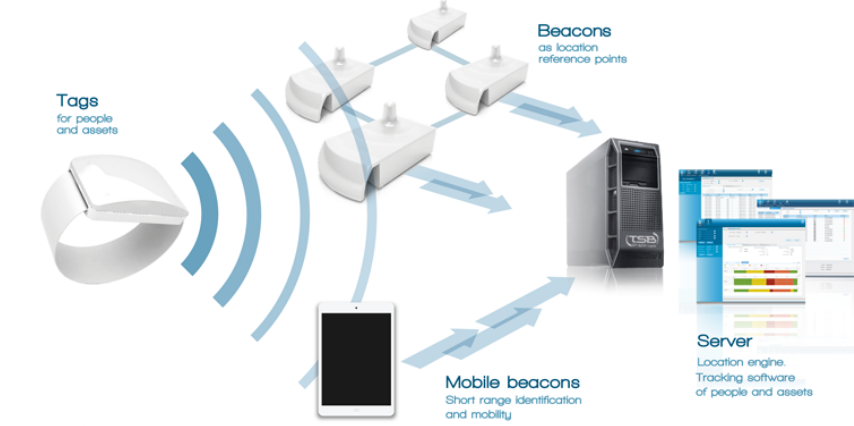
Figure 1. Architecture of the MySphera system [45]. Reproduced with permission from MySphera R (cid:13)